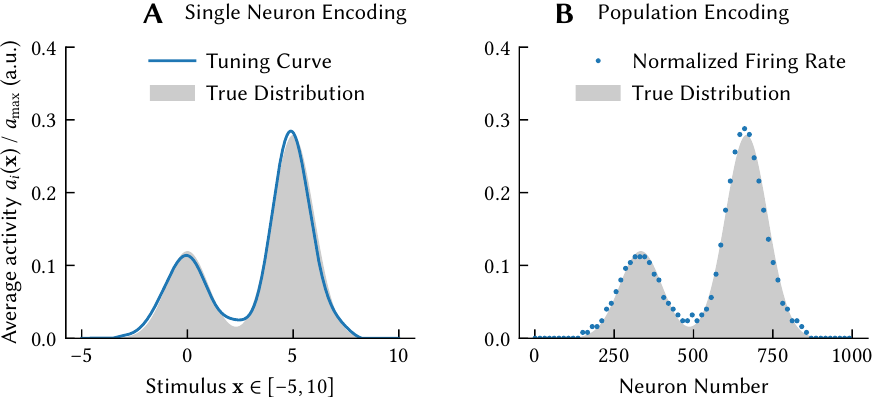
Figure 14. Kernel Density Estimators (KDEs; green line) approximate probability distributions (shaded region). Using the Spatial Semantic Pointer representation we can approximate the Fourier Integral Estimator (FIE)—a density estimator using a sinc kernel function. More importantly, we can represent probability with finite neural resources, and interpret operations on that representation as probability statements. Figure adapted from